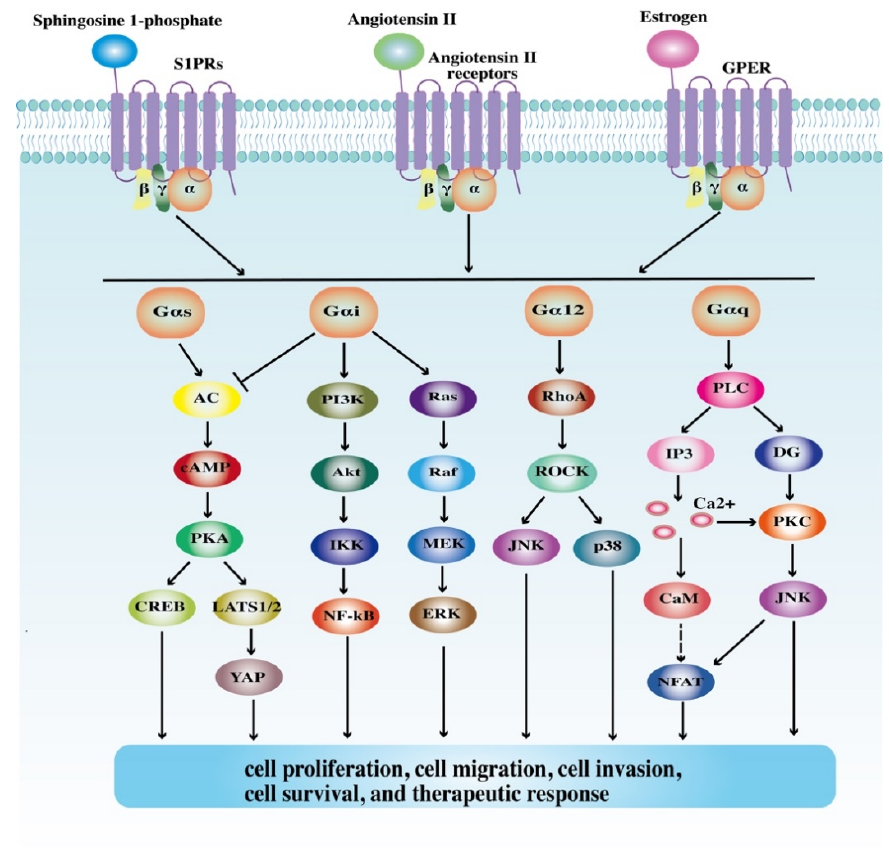
Figure 1. Roles of G protein ‐ coupled receptors (GPCRs) in tumorigenesis and therapeutic response. Various ligands bind to sphingosine 1 ‐ phosphate receptors (S1PRs), angiotensin II receptors, and G protein ‐ coupled estrogen receptor (GPER) and activate downstream pathways including adenylyl cyclase (AC)/cyclic adenosine monophosphate (cAMP)/protein kinase A (PKA), phosphatidylinosi ‐ tol 3 kinase (PI3K)/Akt, Ras/mitogen ‐ activated extracellular signal ‐ regulated kinase (MEK)/extra ‐ cellular signal ‐ regulated kinase (ERK), ras homolog family member A (RhoA)/Rho associated coiled ‐ coil containing protein kinase (ROCK), phospholipase C (PLC)/inositol triphosphate (IP3), and PLC/diacylglycerol (DG)/protein kinase C (PKC) signaling pathways, regulating cell prolifera ‐ tion, migration, invasion, survival, and therapeutic response. 3. Roles of GPCRs in GI Cancers 3.1. Colorectal Cancer Colorectal cancer (CRC) is the most common GI cancer, with 1.9 million new cases and 0.9 million deaths in 2020, becoming the third leading cause of cancer and the second leading cause of cancer mortality in 2020 [1]. Although significant achievements have been made in the therapy of CRC, the mortality remains high [28]. Several lines of evidence indicate that the progression of CRC is a multi ‐ factor and multi ‐ step process [29]. As an important factor for the progression of CRC, GPCRs have provided new insights into CRC tumorigenesis. In this part, we mainly focus on the roles of sphingosine 1 ‐ phosphate re ‐ ceptors, angiotensin II receptors, estrogen ‐ related GPCRs, and some other important GPCRs in CRC (Table 1). Table 1. Roles of G protein ‐ coupled receptors in colorectal cancer. GPCRs